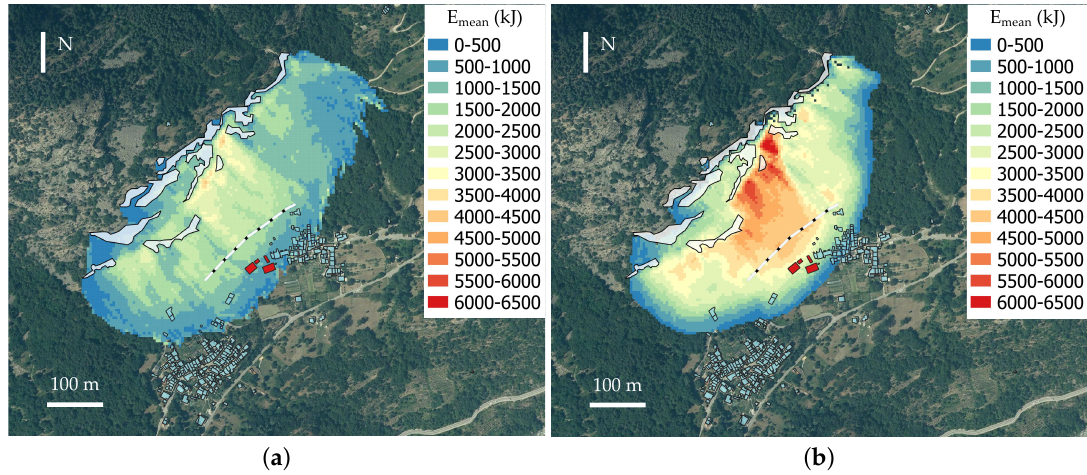
Figure 6. Forecasting analyses of the 5 m 3 rockfall scenario: ( a ) The Rockyfor3D simulation shows a wide runout area involving the inhabited area which was effectively subjected to the 2011 event. Furthermore, the whole hamlet can be interested by this rockfalls; ( b ) the QPROTO analysis highlights the same invasion zones of Rockyfor3D. A little difference in the north-eastern part can be observed, in which the descent paths evaluated in Rockyfor3D canalized into a stream. The energy values computed with QPROTO are higher than Rockyfor3D values because of the different mechanical